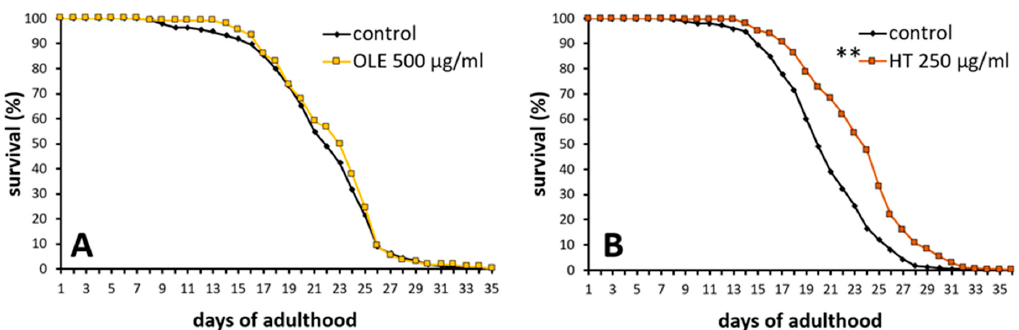
Table 1. Lifespan characteristics during OLE and HT treatment.